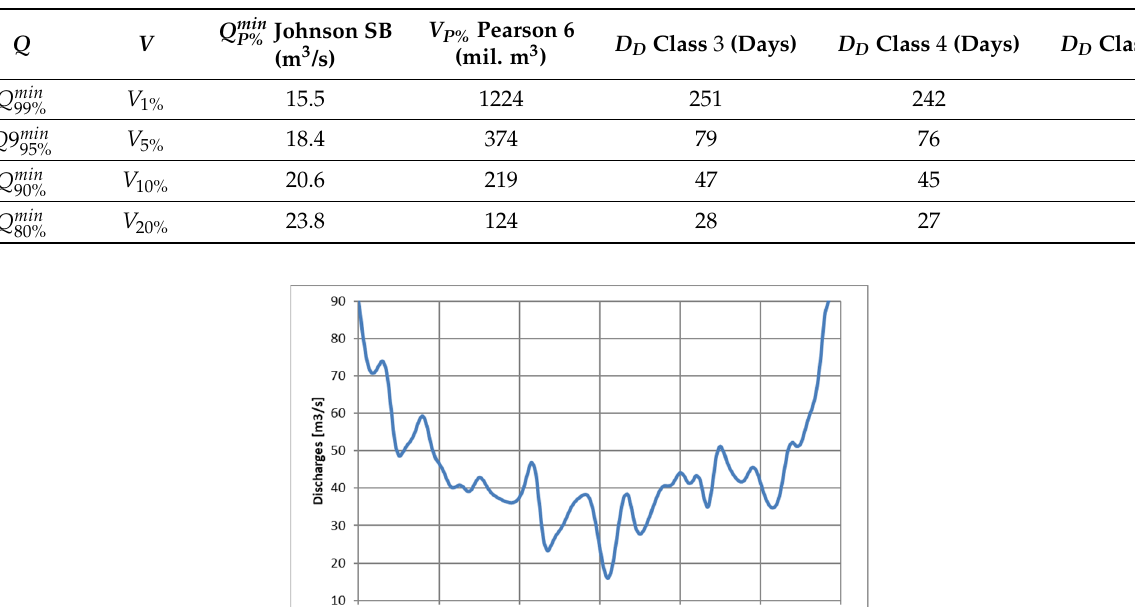
Figure 10. Synthetic drought hydrograph—Class 3.